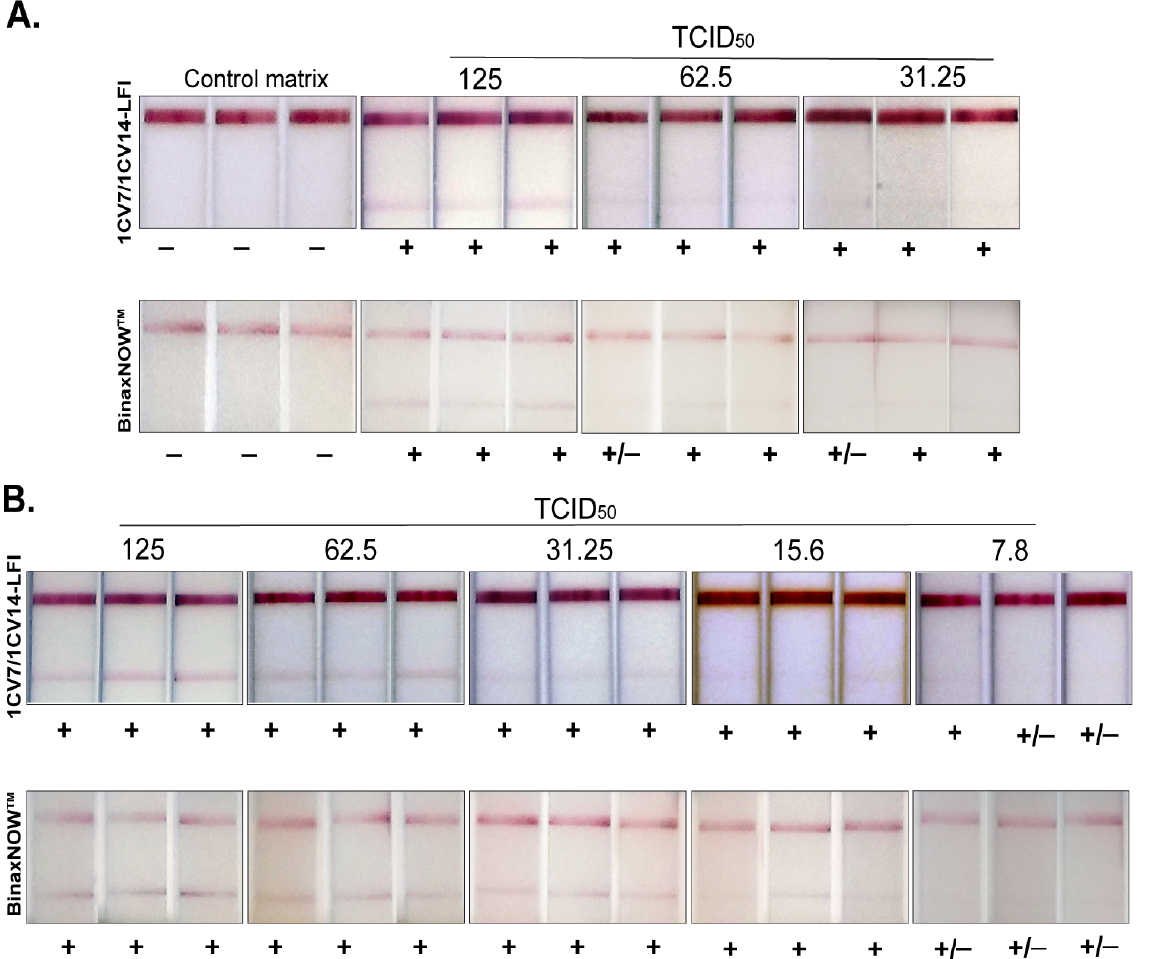
Figure 2. Analytical sensitivities of 1CV7/1CV14 LFI in comparison with BinaxNOW TM for the detection of both Delta ( A ) and Omicron BA.1 ( B ) variants. A control matrix with known amounts of live SARS-CoV-2 virus of the respective variant was loaded onto the 1CV7/1CV14 LFI as well as the BinaxNOW TM test in triplicate. Signals were recorded through visual inspection of the test lines.